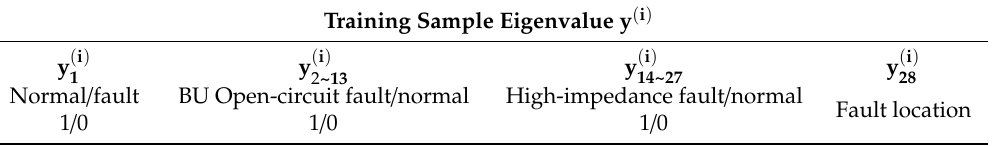
Table 2. Calibration value of training